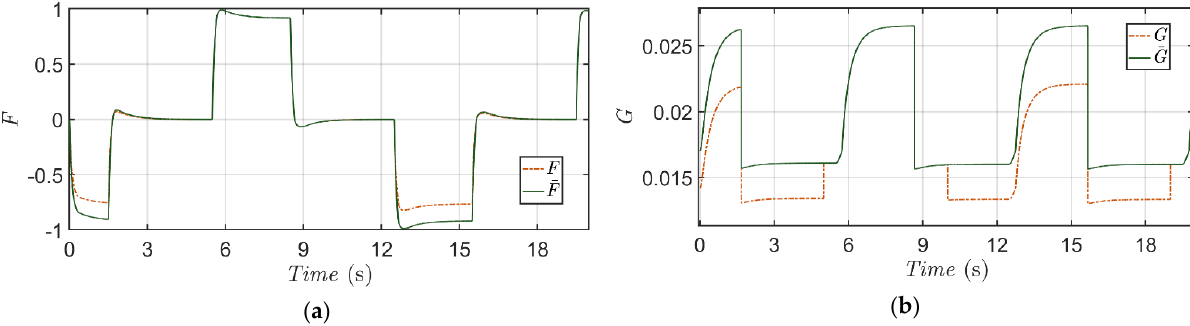
Figure 8. Comparisons of model functions F and G (green line) with F and G (red dotted line) in Scenario 1. ( a ) F and F , ( b ) G and G .